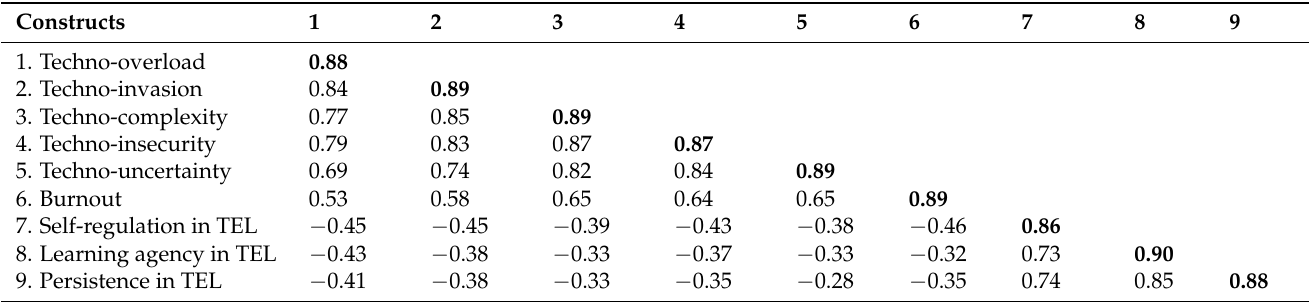
Table 2. Discriminant validity of the research model.